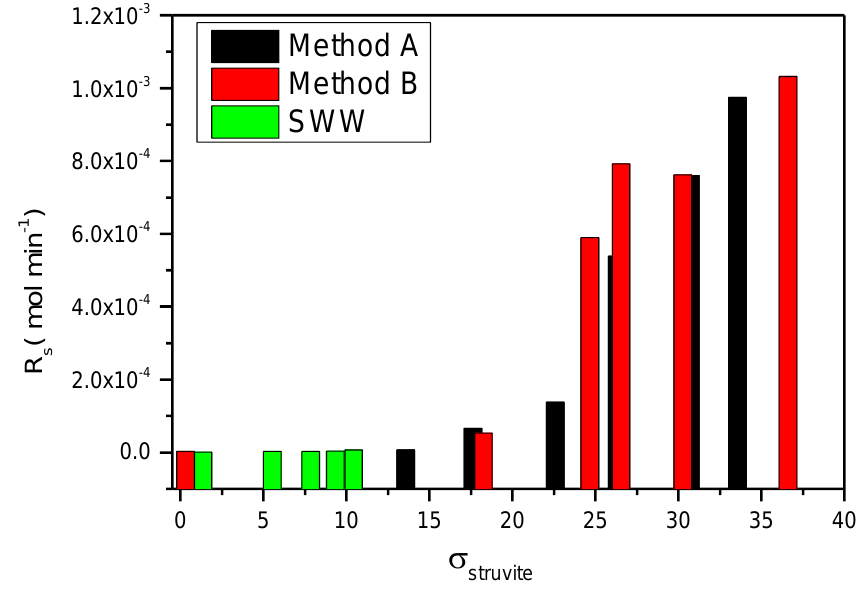
Figure 12. Precipitation of struvite from supersaturated solutions: ( ◼ ) Method A; ( ◼ ) Method B; ( ◼ ) synthetic wastewater; 25 °C.